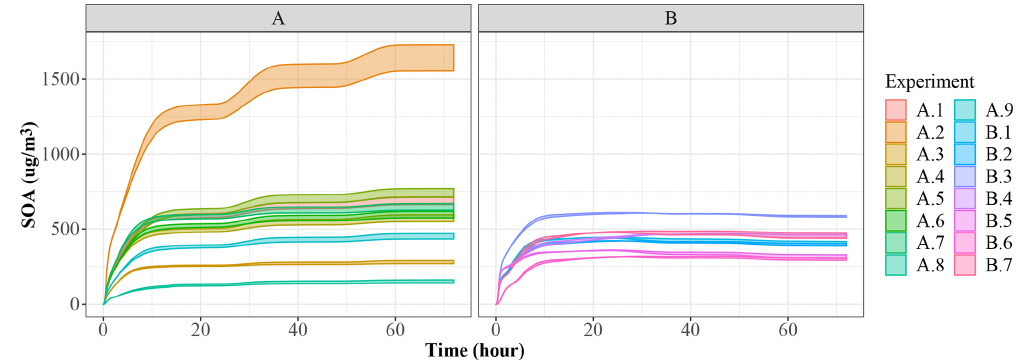
Figure 5. Time series plot of SOA mass from the same case studies used in profiling total simulation time. In this study, as noted in the text, we use a predictive technique that under-predicts the saturation vapour pressure to create the maximum number of viable condensing products. Table 3. Comparison between JlBox and PyBox.